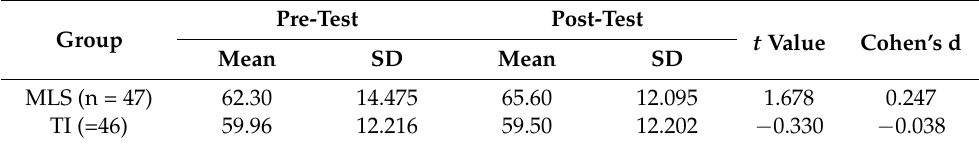
Table 3. Descriptive statistics of the pretest and posttest scores of mathematics learning interest